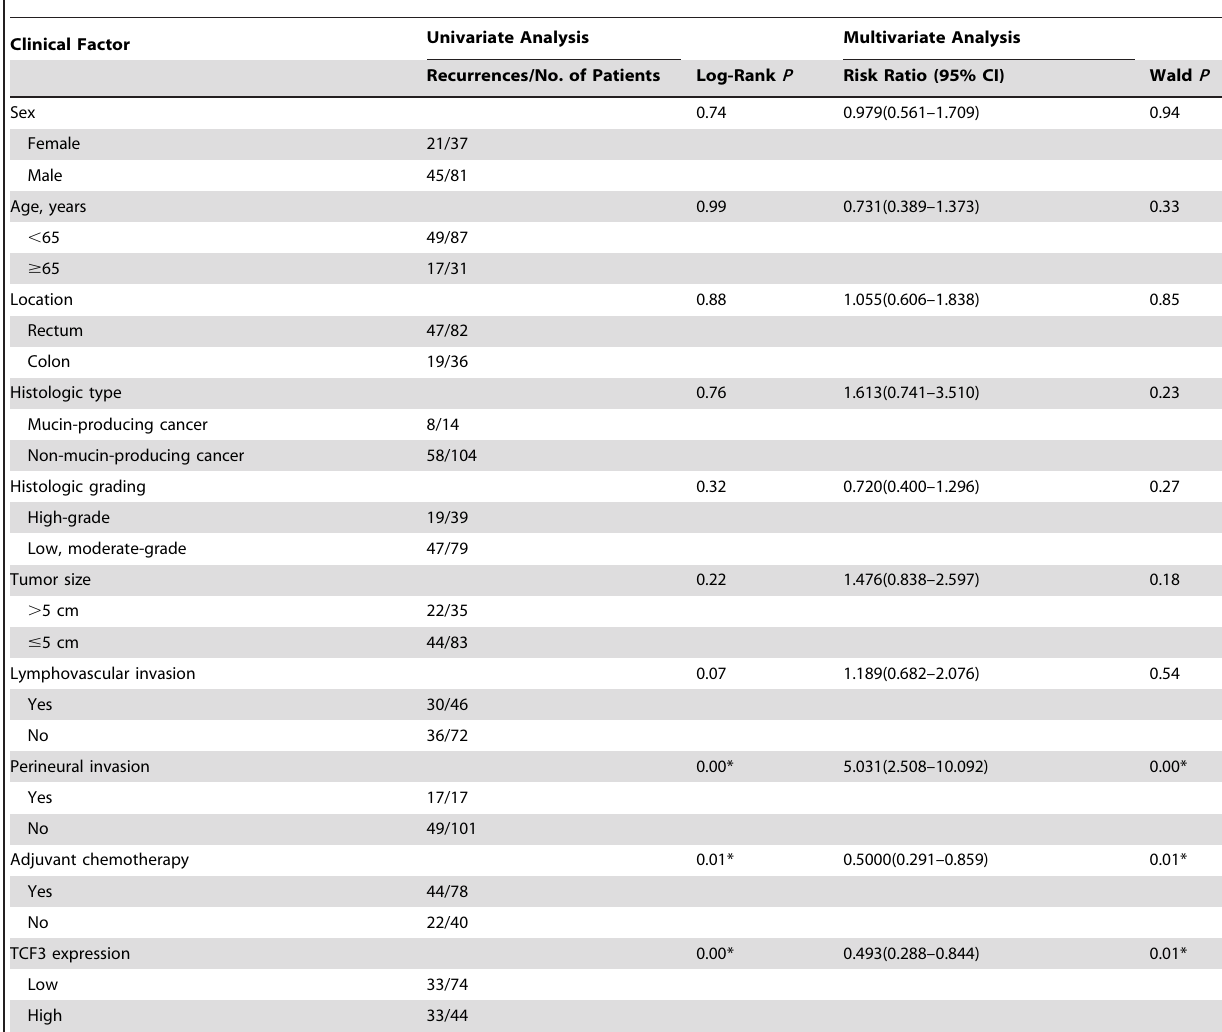
Table 4. Univariate and multivariate analyses of disease-free survival in stage II/III CRC.